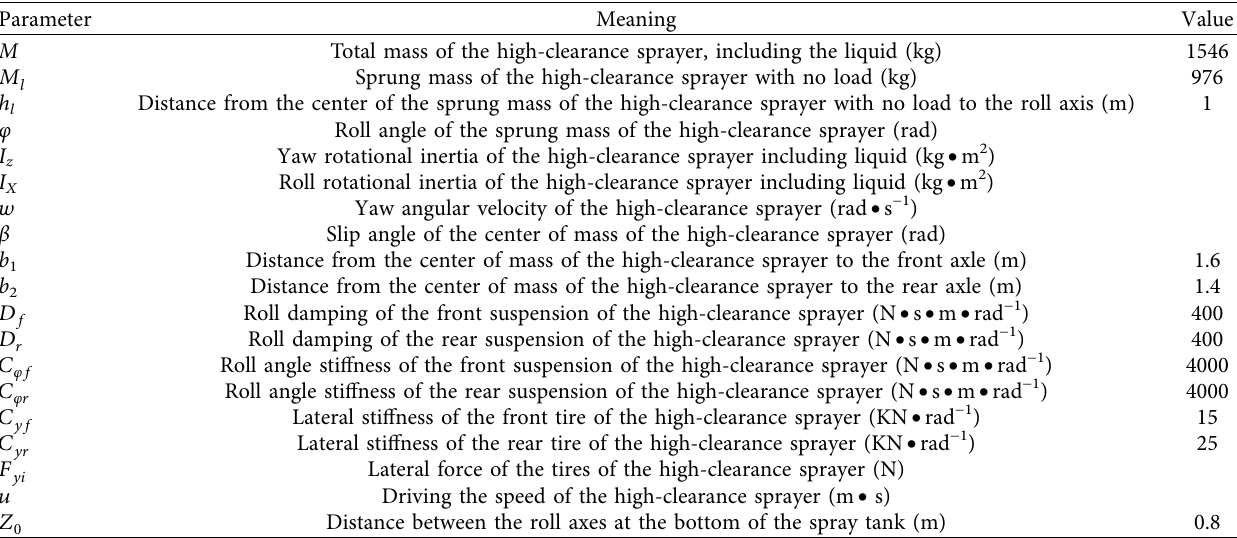
Table 8: System parameters.